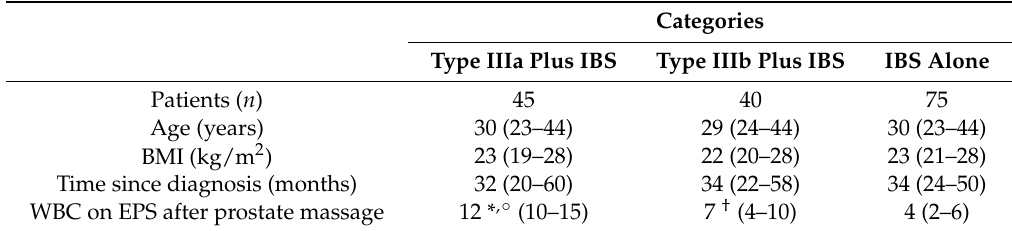
Table 1. Baseline characteristics of patients with chronic prostatitis (Type IIIa or IIIb) plus irritable bowel syndrome (IBS), or with IBS